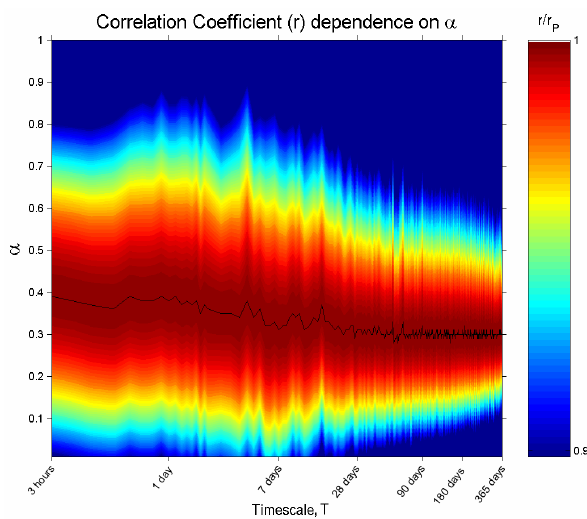
Figure 7. Fig. 7. Colour contours of the correlation coefficient r, between P α and the am geomagnetic index, as a ratio of its peak value at that T, r p , as a function of the averaging timescale T (on a logarithmic scale) and the value of the coupling exponent α